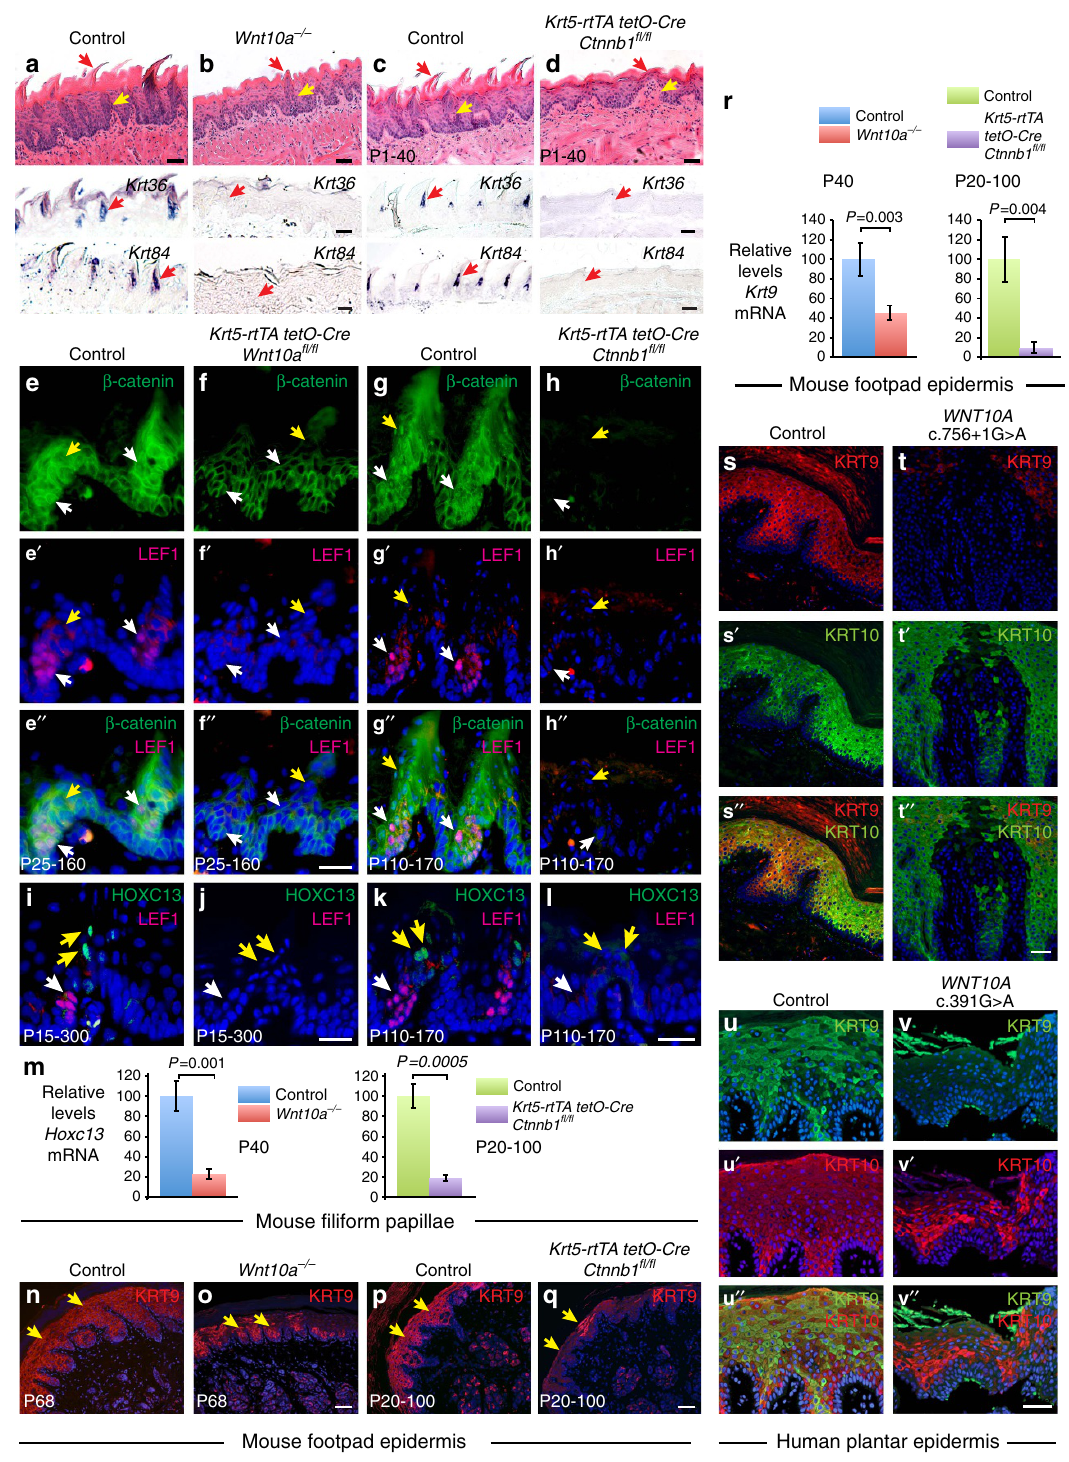
Figure 9 | WNT10A/ b -catenin signalling is required for region-specific differentiation. ( a – d ) Filiform papillae are present in Wnt10a (cid:2) / (cid:2) and inducible b -catenin mutant dorsal tongue (yellow arrows), but horny structures and expression of hard keratins ( in situ hybridization, purple signals) are decreased (red arrows). ( e – l ) Epithelial deletion of Wnt10a ( e – f 00 , i , j ) or b -catenin ( g – h 00 , k , l ) induced from P25, P110 or P15 as indicated causes decreased expression of nuclear b -catenin, LEF1 and HOXC13 (white arrows, LEF1 þ proliferating cells; yellow arrows, HOXC13 þ differentiating cells). ( m ) qPCR shows significantly decreased Hoxc13 levels in Wnt10a and b -catenin mutant tongue epithelium. ( n – r ) IF and qPCR reveal reduced levels of KRT9 protein ( n – q ) and mRNA ( r ) in Wnt10a (cid:2) / (cid:2) and inducible b -catenin mutant footpad epidermis. ( s – v 00 ) Co-IF for KRT9 and KRT10 in plantar epidermis from patients homozygous for WNT10A c.756 þ 1G 4 A ( s – t 00 ) or WNT10A c.391G 4 A ( u – v 00 ) compared with similarly aged sex-matched controls. For qPCR, RNA levels were quantified in six control and six mutant (P40) or four control and four mutant (P20-100) samples with three technical replicates for each, and normalized to b -actin mRNA. Significance was calculated with two-tailed Student’s t -test. Error bars indicate s.e.m. Scale bar, 25 m m ( e – l ) or 50 m m ( a – d , n – q , s – v 00 ).